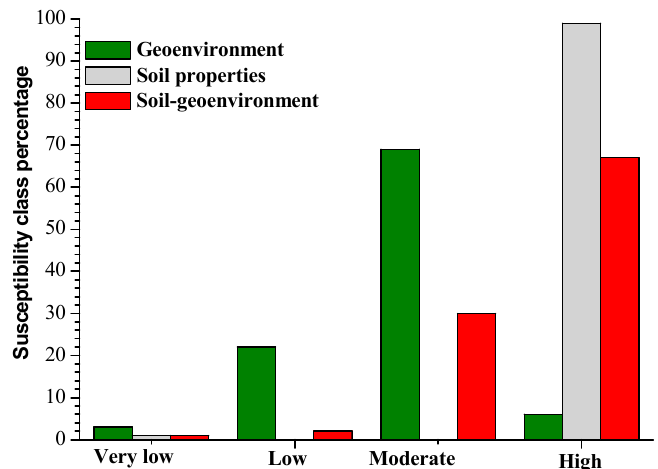
Figure 11. Variation of the landslide-susceptibility models class percentages: Geo-environmental factors in dark green; soil properties in light grey; soil properties merged with geo-environmental factors in red color.